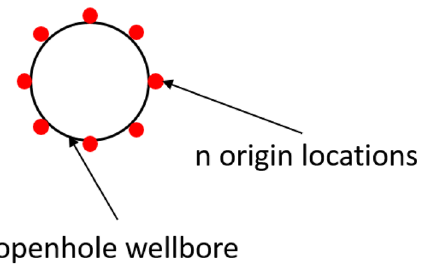
Fig. 3 Conceptual sketch of picking multiple origin locations around an openhole wellbore. The assumed origin locations can be user- specified or gridded throughout the entire specimen if no a priori information exists